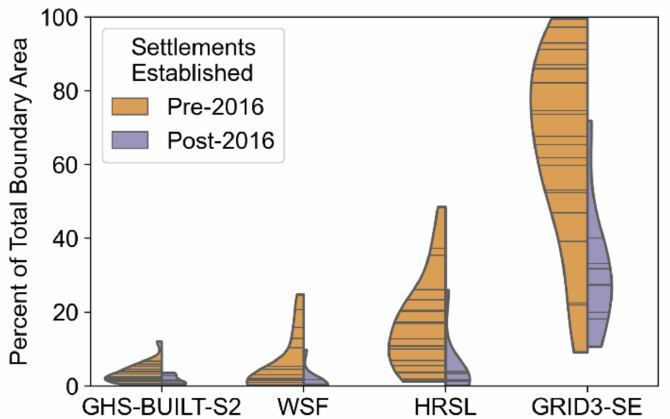
Figure 7. Violin plots of settlement product coverage as a percentage of the refugee settlement boundary area. Pre-2016 settlements were established before 2016, while post-2016 settlements were established in 2016 or later. Black horizontal lines in violin plots represent individual settlement ob- servations. GHS-BUILT-S2, Global Human Settlement Layer with Sentinel 2; WSF, World Settlement Footprint; HRSL, High Resolution Settlement Layer; GRID3-SE, Geo-Referenced Infrastructure and Demographic Data for Development settlement extent